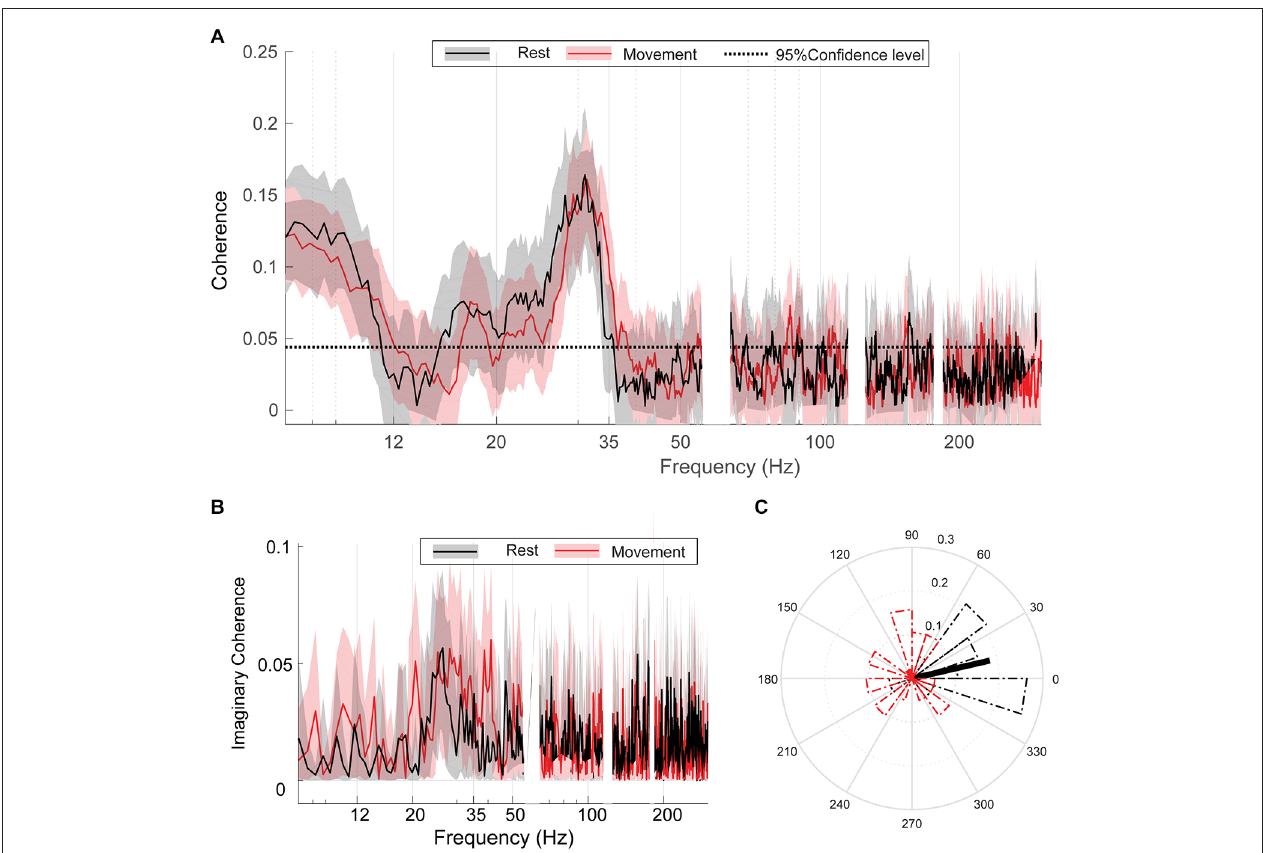
FIGURE 3 | Bilateral GPi are coherent regardless of movement condition. (A) Group average coherence between bilateral GPi during rest (black) and movement (red) indicating statically significant coherence (greater that 95% confidence level: dashed black line) which does not differ between conditions. (B) Group average imaginary coherence (iCoh) during rest (black) and movement (red). (C) Circular histograms of the preferred phase difference between bilateral GPi during rest (black) and movement (red). Thick black/red lines indicate direction of mean phase difference between the two nuclei during rest/movement. Each box contains the interquartile range and whiskers extend to the highest and lowest